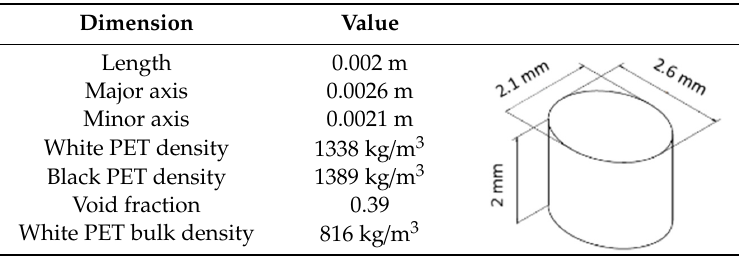
Table 2. Properties of the PET particles .